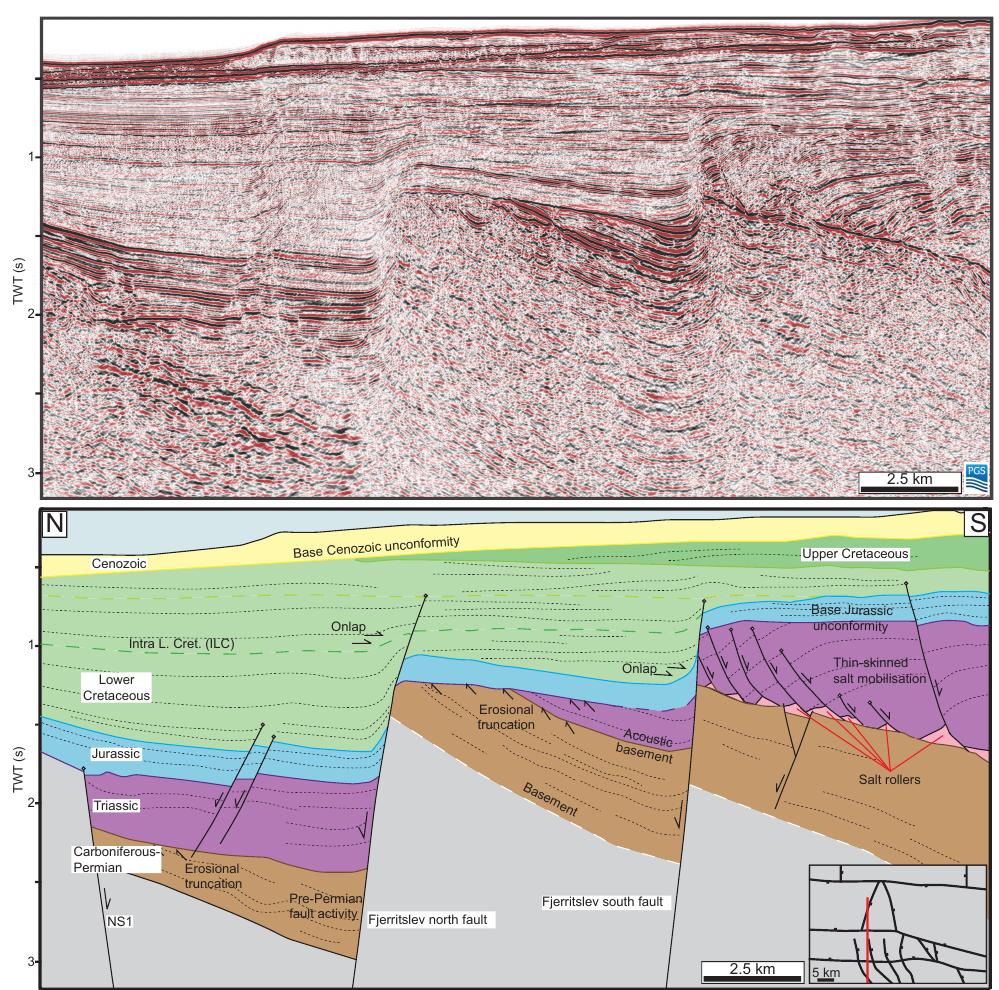
Figure 4. Uninterpreted and interpreted N–S-oriented 2-D seismic section across the Farsund Basin. The Fjerritslev south fault appears to show solely Early Cretaceous activity, with some apparent Triassic activity preceding Early Cretaceous activity along the Fjerritslev north fault. No pre-Permian activity is apparent across either fault. See Fig. 1c for